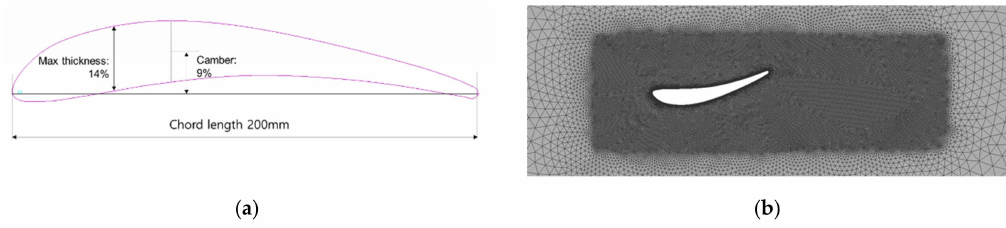
Figure 4. Isolated rear spoiler geometry: ( a ) Airfoil shape; ( b ) Partial view of computational mesh.